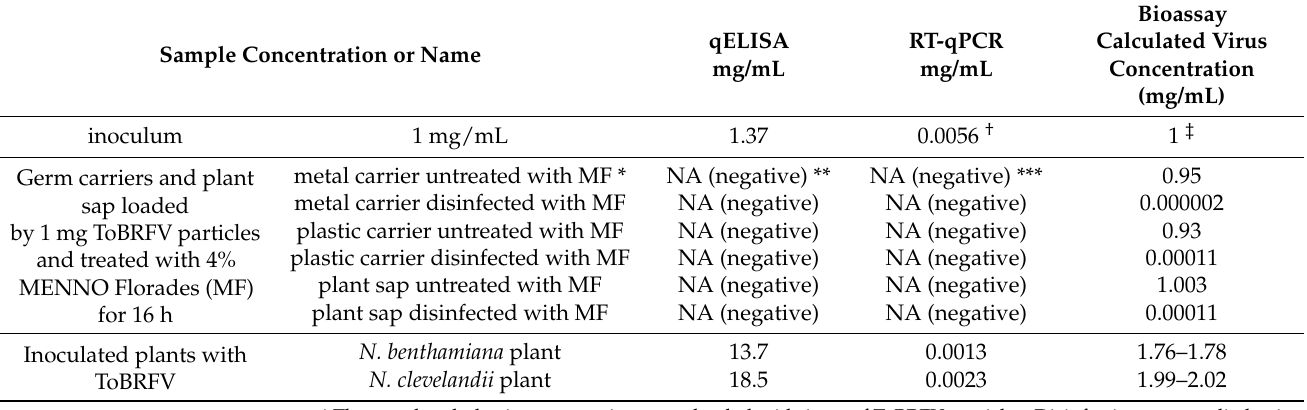
Table 5. Overview of estimated ToBRFV load using qELISA, RT-qPCR, and